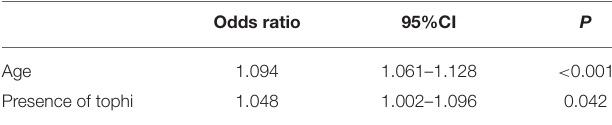
TABLE 2 | The univariate binary logistic regression analysis to determine risk factors for peripheral neuropathy (VPT > 15V) in patients with